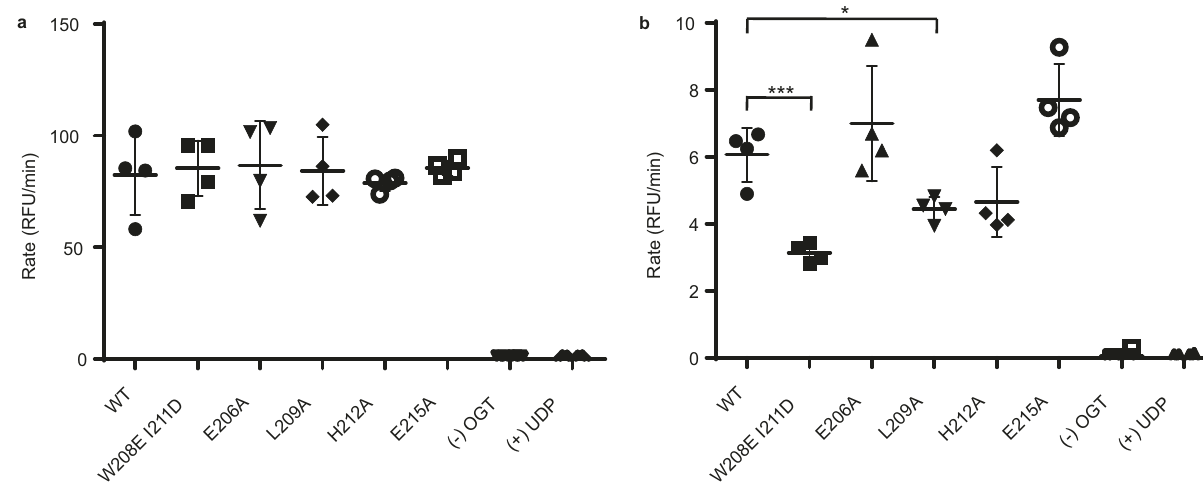
Fig. 3 Transferase activity of the dimer disrupting mutants. a OGT wildtype and mutants were tested for their catalytic activity against HCF-1 peptide using 3 µ M BODIPY-UDP-GlcNAc, 10 µ M HCF-1 peptide, and 20 nM OGT. b OGT wildtype and mutants were tested for their catalytic activity against TAB1 protein in the presence of 10 µ M BODIPY-UDP-GlcNAc, 0.6 µ M TAB1, and 100 nM OGT. Measurements were performed in quadruplicate and yielded similar data in two biological replicates. Error bars represent one standard deviation (SD) from the mean. *P = 0.0101, ***P = 0.0005; two-tailed t -tests. Source data are provided as a Source Data fi